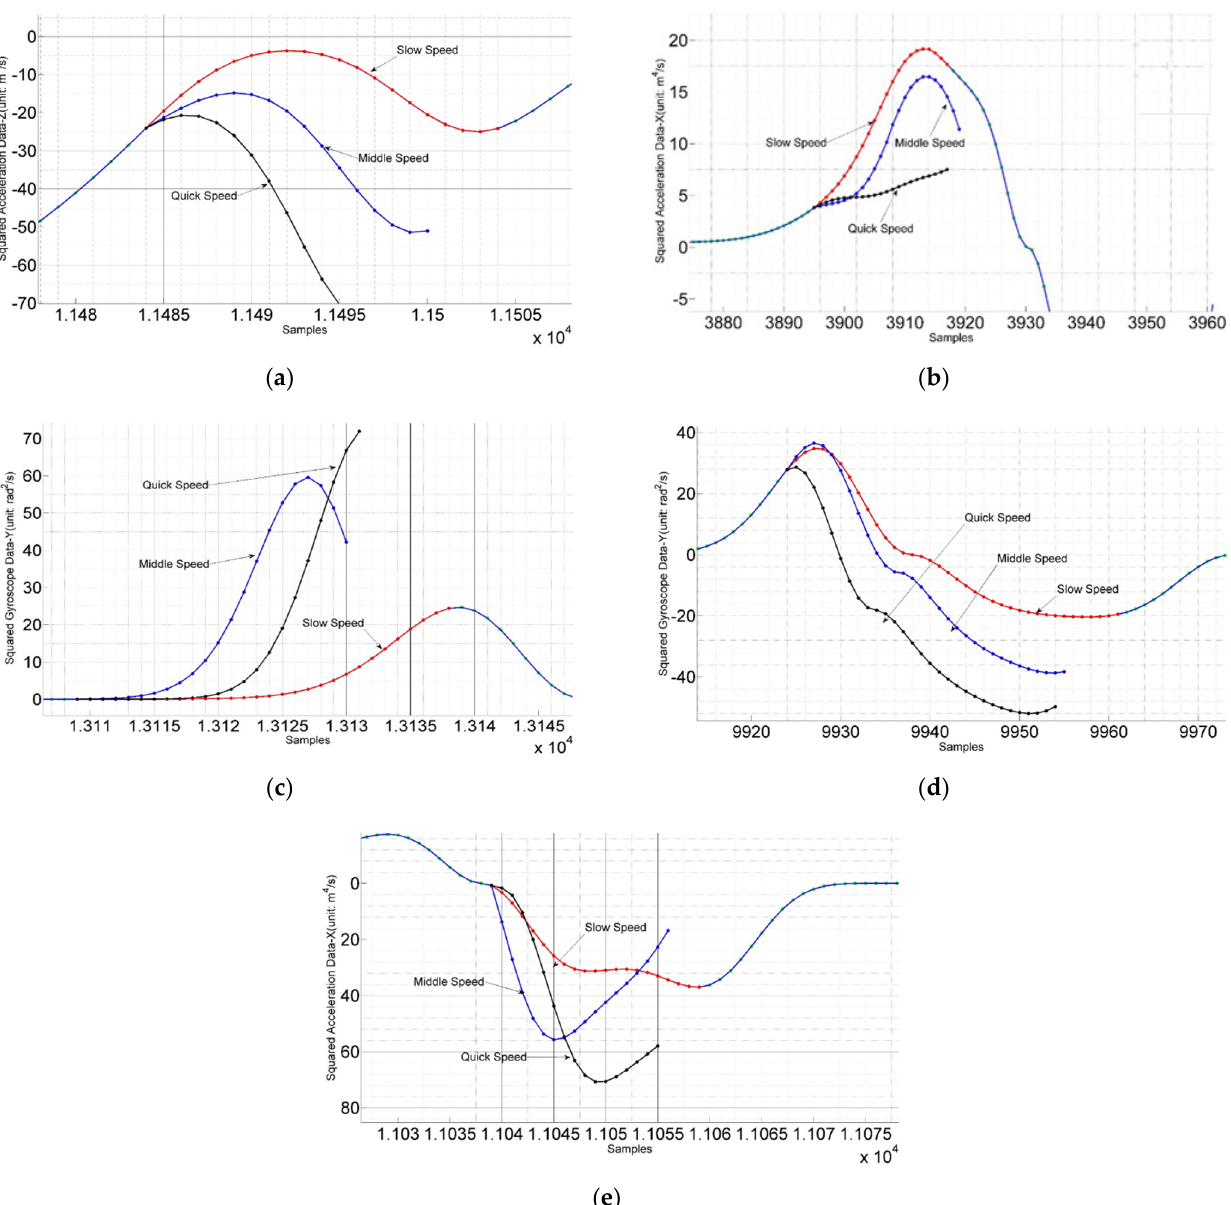
Figure 1. The magnitude of the sensor signal mutation at different walking speeds ( a ) The left and right direction gyroscope signals at different speeds in the stage when the foot is pushing off the ground ( b ) The acceleration signals of the front and rear directions at different speeds in the stage when the foot is pushing off the ground ( c ) In the foot swing stage, the left and right direction signals of the gyroscope at different speeds ( d ) The acceleration signal of the front and rear directions at different speeds during the heel-to-ground cushioning stage ( e ) The vertical acceleration signal at different walking speeds in the heel-to-ground cushioning stage.